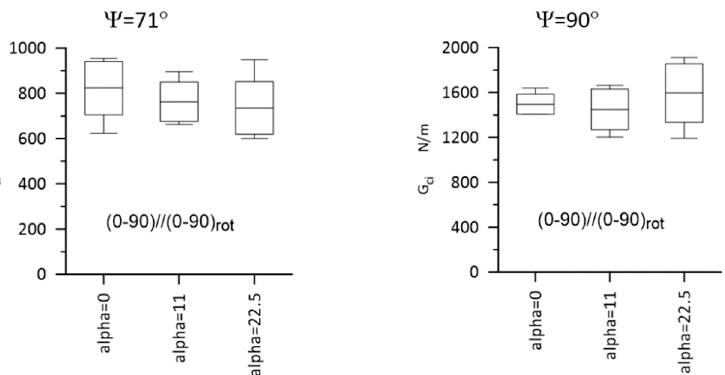
Figure 16. Gci values SERR for Laminate B, for Ψ = 71°, and for 90°. The whiskers limit the extreme values, the middle bars represent the mean values, and the boxes represent the standard deviations. Statistically significant differences were not detected.